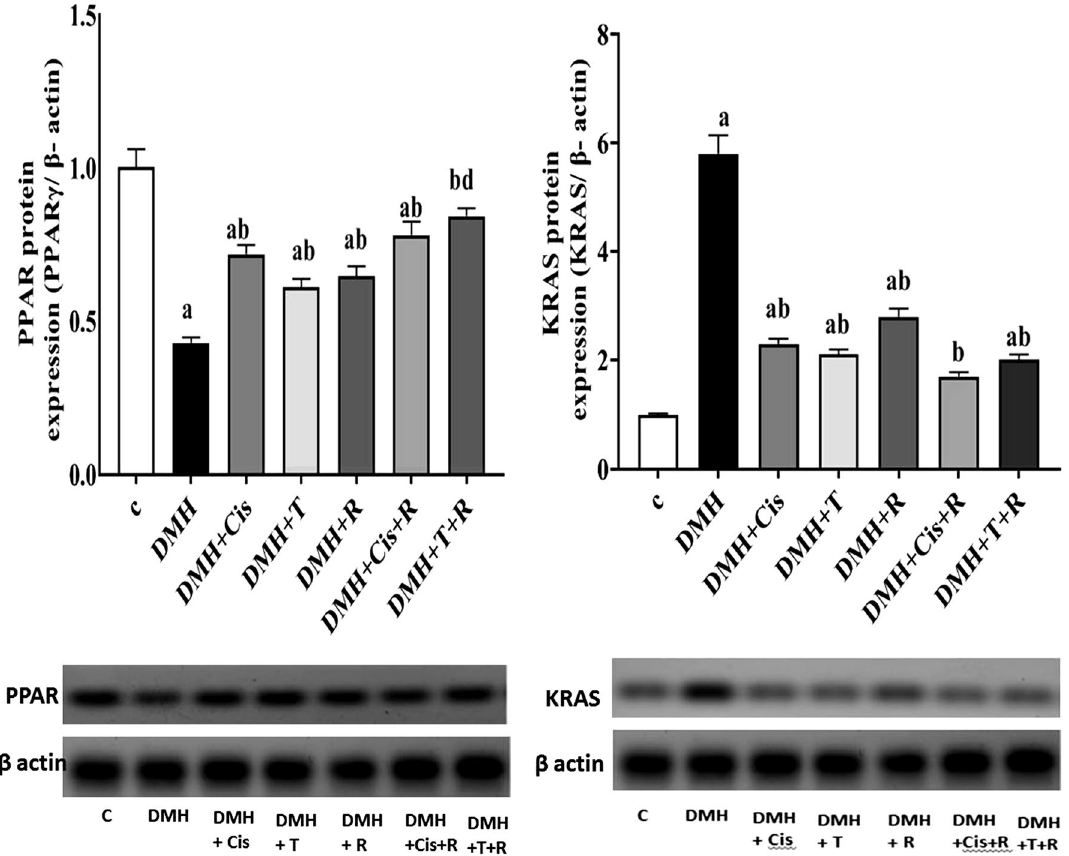
Fig. 7 Effect of thiophene derivative and low dose γ-irradiation on p53 and cas- pase-3 expression. C: control, DMH: dimethyl hydrazine, Cis: cisplatin, T: thiophene deriva- tive, R: radiation. Values are the mean ± SEM (n = 6). a Sig- nificant change compared to the control group. b Significant change compared to DMH group. C Significant change compared to DMH + Cis. d Significant change compared to DMH +